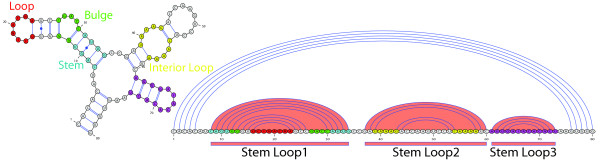
Secondary structure elements of an RNA molecule represented by a base-pair graph (left) and as arc-annotated sequence (right). The depicted structure contains three stem-loop substructures. Observe that all arcs representing base pairings are non-crossing and stem-loop substructures can contain interior loops and bulges. Hence this molecule forms a non-crossing secondary structure that does not contain higher order structural elements like pseudoknots. Secondary structure drawings were generated with the VARNA program [55].